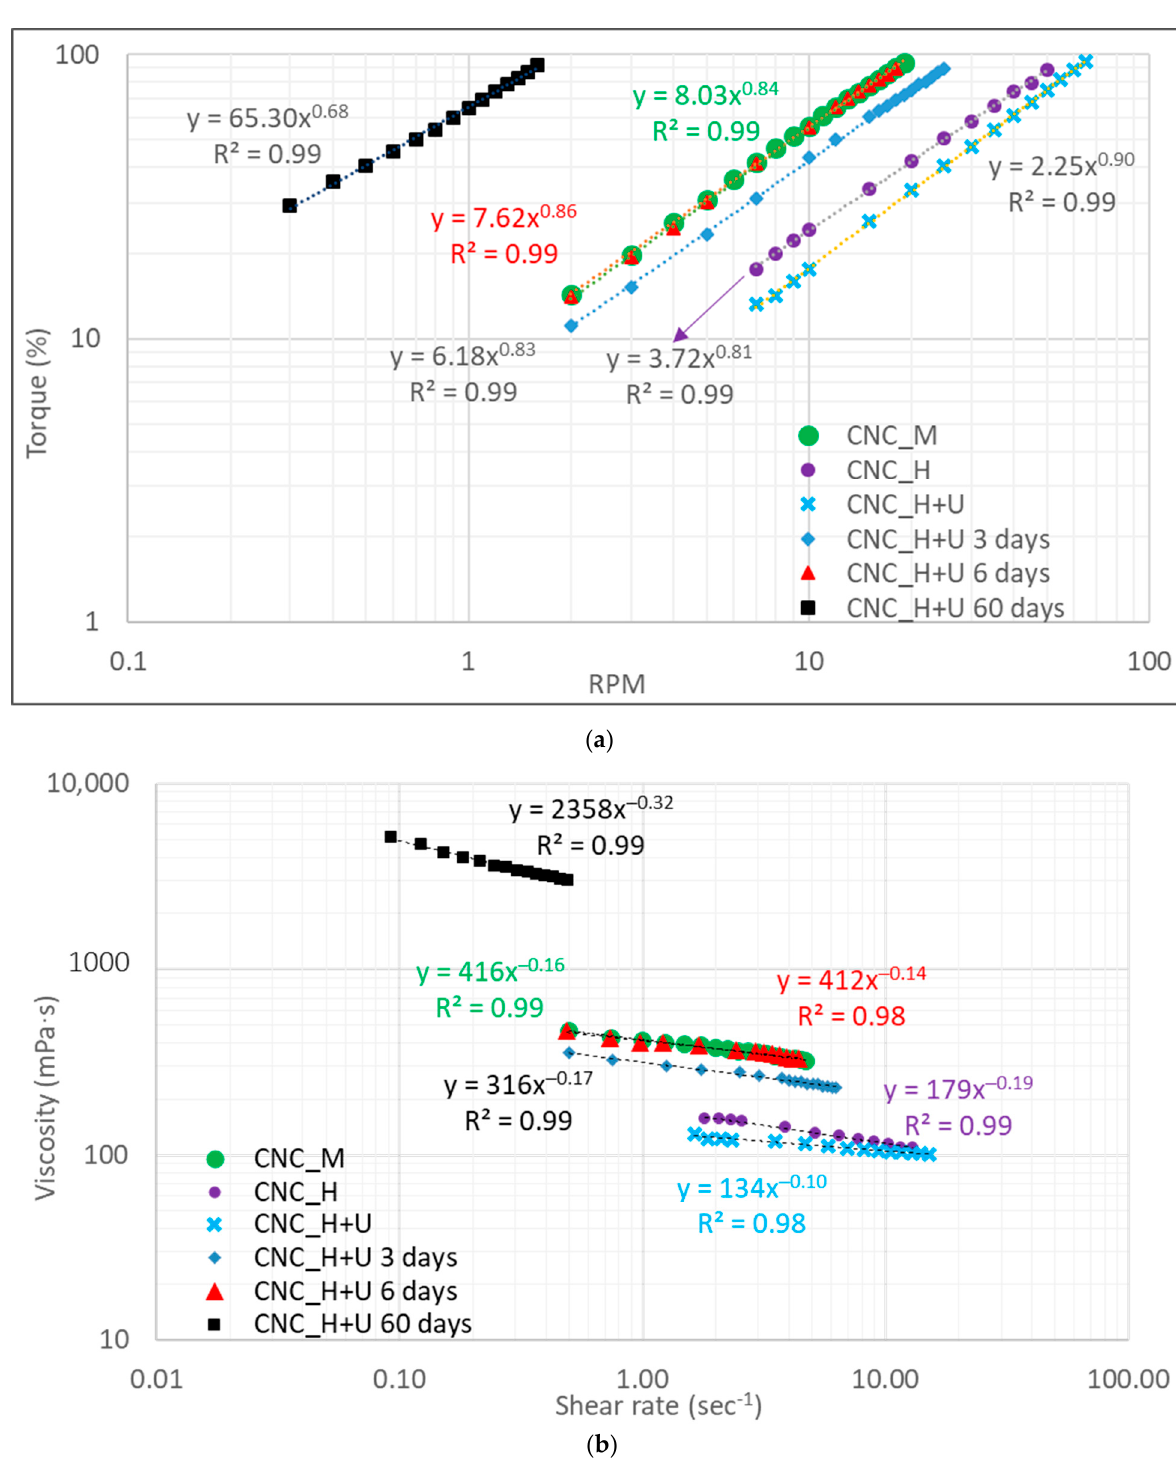
Figure 3. The change of viscosity with time for the CNC_H+U suspension ( a ) torque versus RPM and ( b ) viscosity versus shear rate.